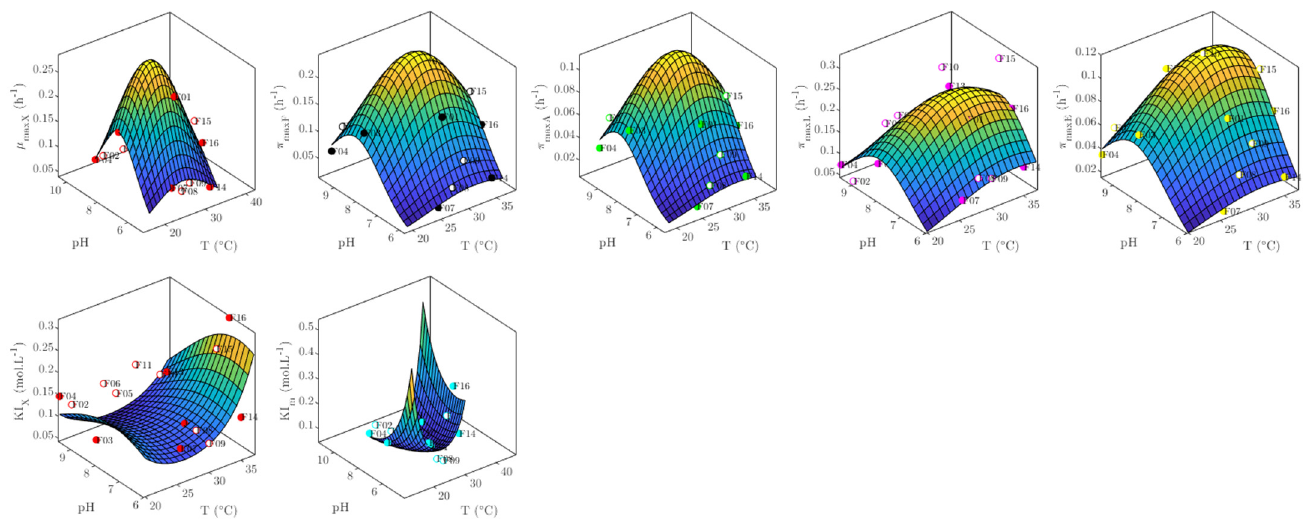
Figure 6. Response surfaces for model parameters, calculated with globally adjusted β coefficients in Equation (17). For completeness, the final values of the regression coefficients of Equation (17) for the seven adjustable parameters of the dynamic model are reported in Appendix A Table